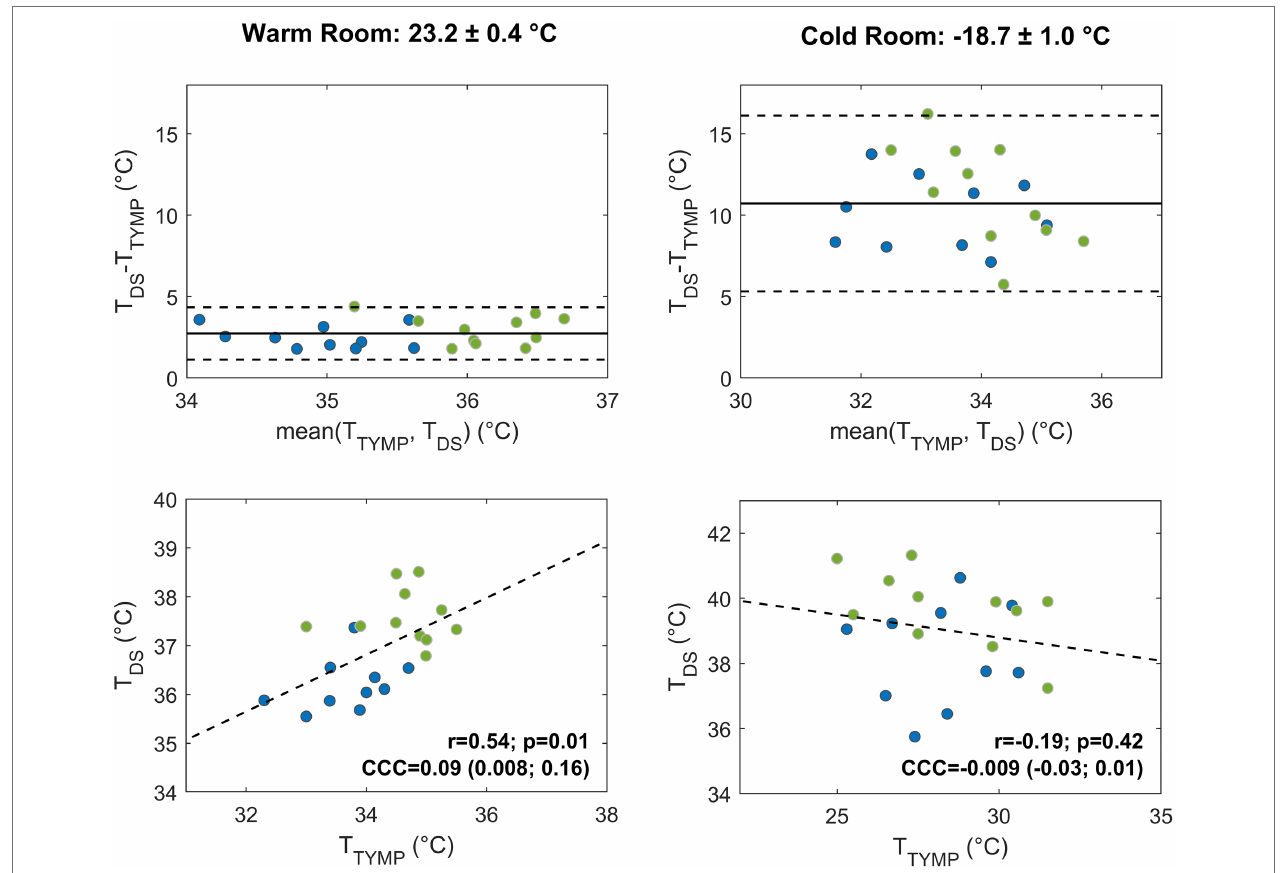
FIGURE 5 | Agreement between temperature values measured by the forehead double sensor (T DS ) and the tympanic sensor (T TYMP ) after 9 min in the warm (left) and cold room (right) settings. Bland–Altman plots and correlation plots are displayed in the upper and in the lower panels, respectively, and subjects are color- coded according to the randomization groups (group A, blue; group B, green). In the Bland–Altman plots, the solid line indicates the mean difference and the dashed lines the limits of agreement (mean ± 1.96 standard deviation) for the overall population. In the correlation plots, the linear regression line (dashed line), Pearson’s correlation coefficient (r) with value of p (p), and Lin’s CCC and confidence interval, are indicated for the overall